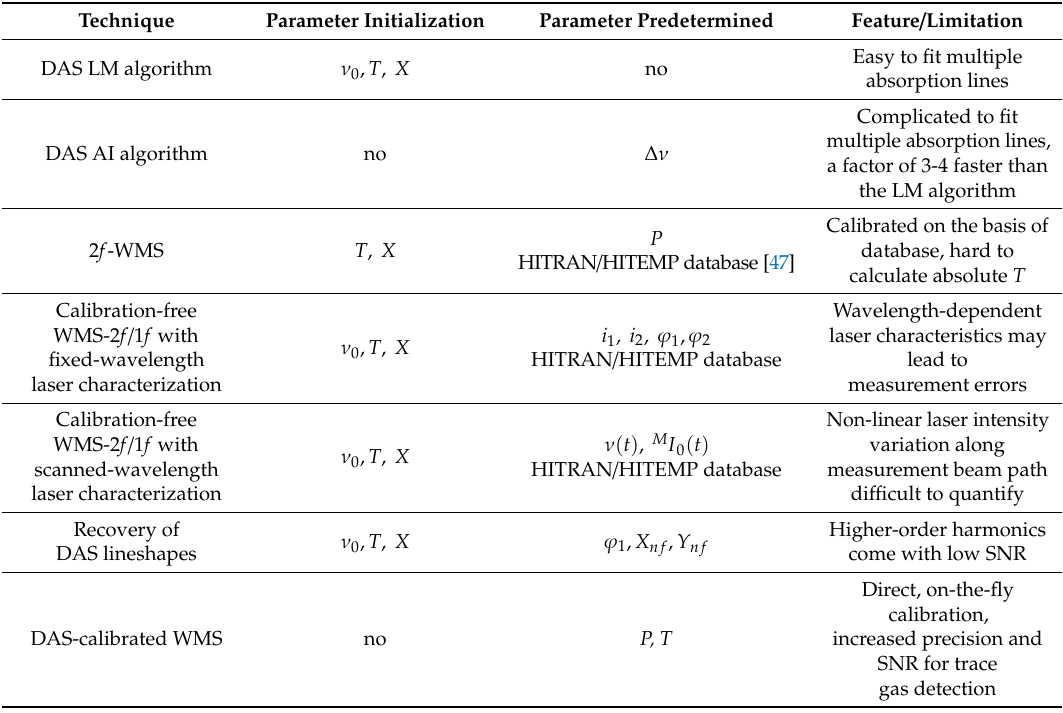
Table 1. Comparison of fitting algorithms in direct absorption spectroscopy (DAS) and wavelength modulation spectroscopy (WMS) techniques. LM: Levenberg–Marquardt, AI: advanced integrative, SNR: